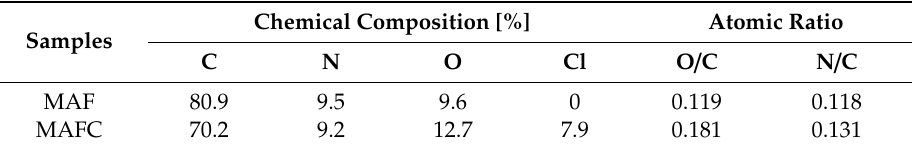
Figure 4. X-ray photoelectron spectroscopy (XPS) wide-scan spectra and Cl 2p spectra of ( a , c ) MAF and ( b , d ) MAFC. Table 2. XPS surface element analysis of MAF before and after treatment.